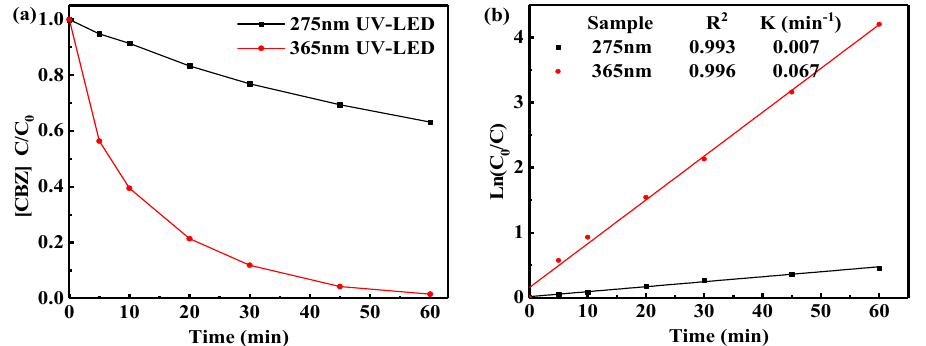
Figure 3. ( a ) Degradation of CBZ by UV-LED/TiO 2 using different wavelengths of UV-LED. ( b ) The pseudo-first-order kinetic models of CBZ degradation by UV-LED/TiO 2 using different wavelengths of UV-LED . C(CBZ) 0 = 18.8 µM; operating temperature = 20 °C; wavelength of UV-LED: 365 nm; I 0 = 774 µW/cm 2 , operating pH = 7.6; and C (mixed-phase TiO 2 ) = 2.0 g/L.